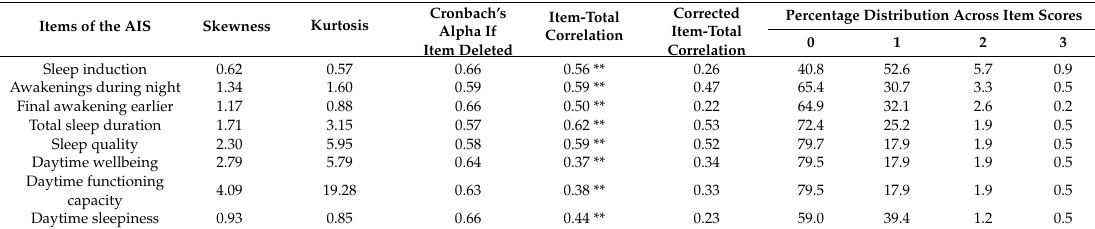
Table 7. Descriptive statistics, communality, item-discrimination, factor loadings of the Athens Insomnia Scale (AIS) among occupational computer users in